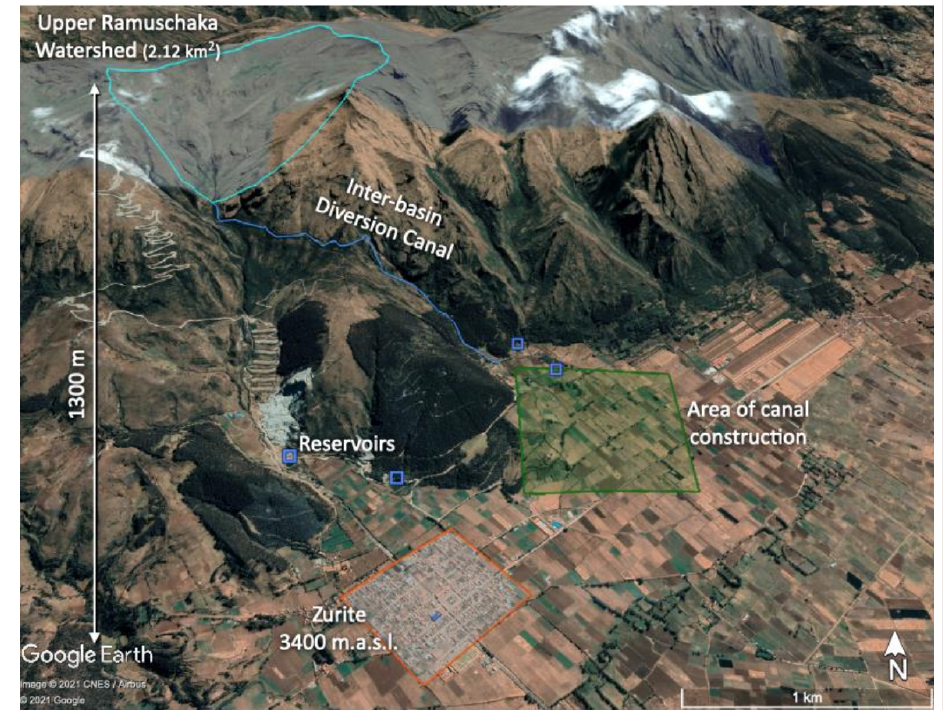
Figure 4. Zurite and the Upper Ramuschaka Watershed (URW). The URW is located 1300 m above the village, within the puna biome. Water is often diverted from the URW via an inter-basin canal for irrigation to the east of Zurite. Blue squares show the locations of 4 surface reservoirs, and the green-shaded area shows the area in which we collaborated with the local community to construct 1.3 km of irrigation canals (map and photo